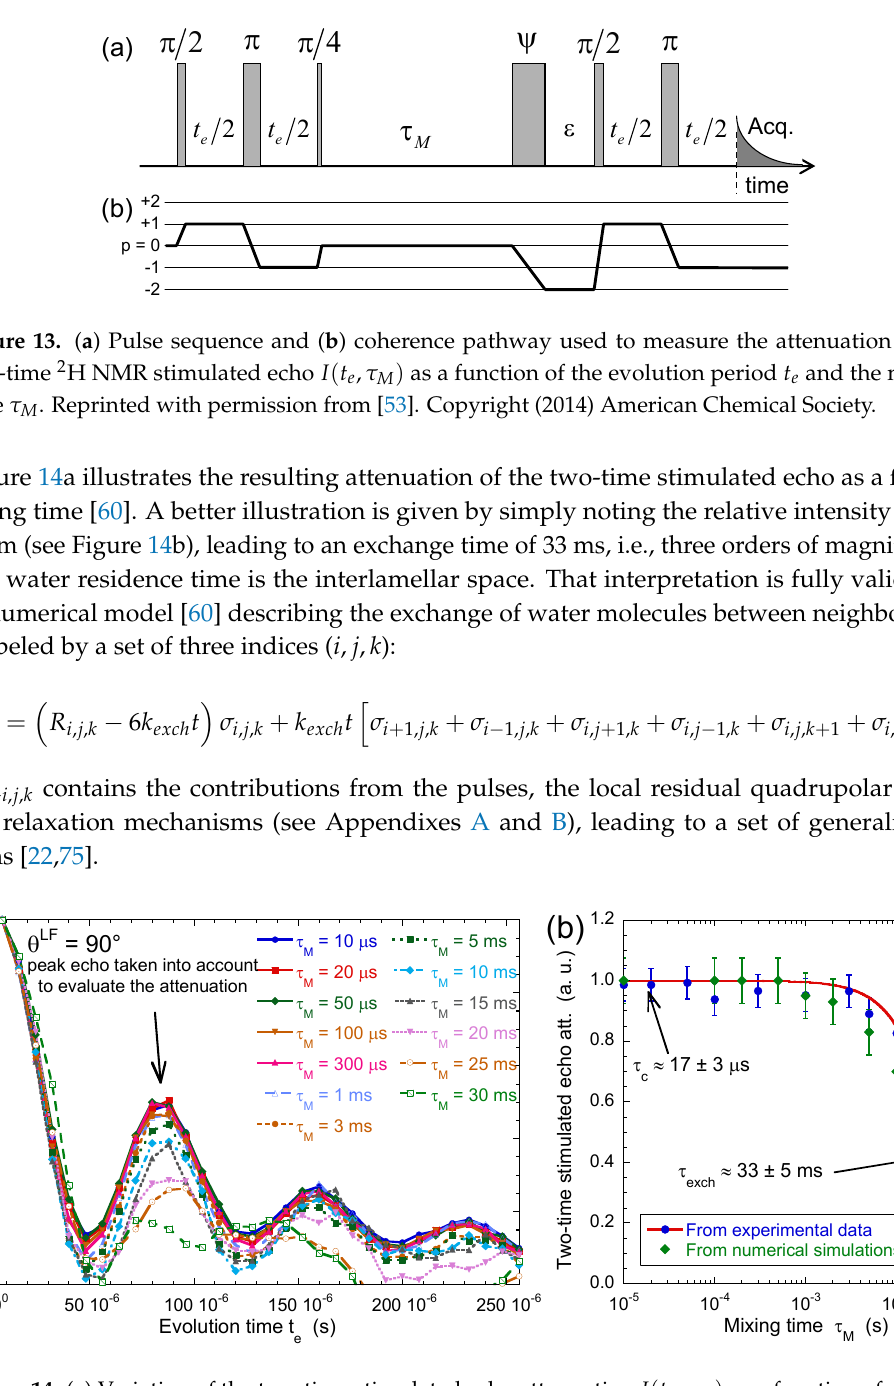
Figure 14. ( a ) Variation of the two-time stimulated echo attenuation I ( t e , τ M ) as a function of mixing time τ M ( 2 H NMR). The data are normalized to take into account the relaxation of the T 20 coherence during the mixing time τ M (see Equation (3)). ( b ) Two-time correlation function extracted from the normalized stimulated echo attenuation as a function of the mixing time τ M . The red line corresponds to the best fit of a stretched exponential function, f ( t ) = A exp ( − t / τ exch ) α , to determine the exchange time τ exch ( τ exch = 33 ± 5 ms with an exponent α set equal to 1.5), and the green line dots are obtained by numerical modeling (see the text). Reprinted with permission from [53]. Copyright (2014) American Chemical